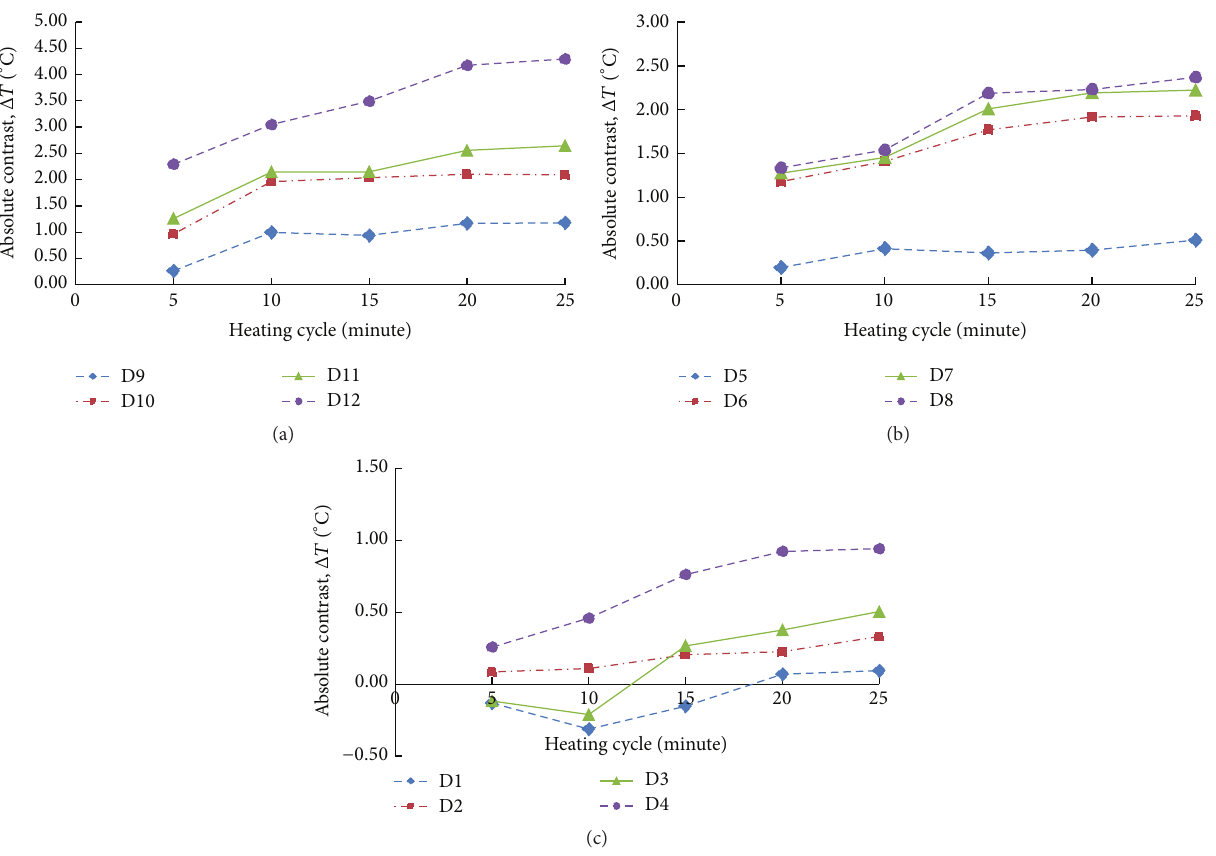
Figure 5: Absolute contrast of delaminations at (a) 1cm, (b) 2 cm, and (c) 3 cm in depth for the five heating